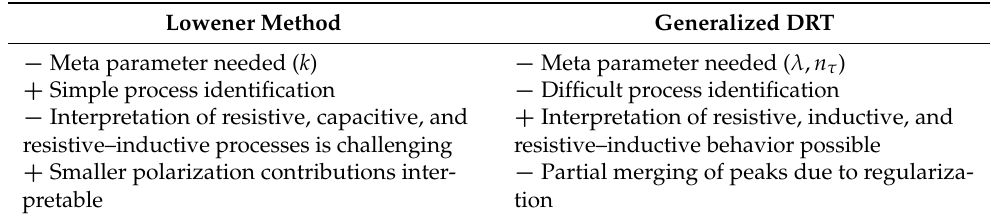
Table 1. Advantages and disadvantages of LM and